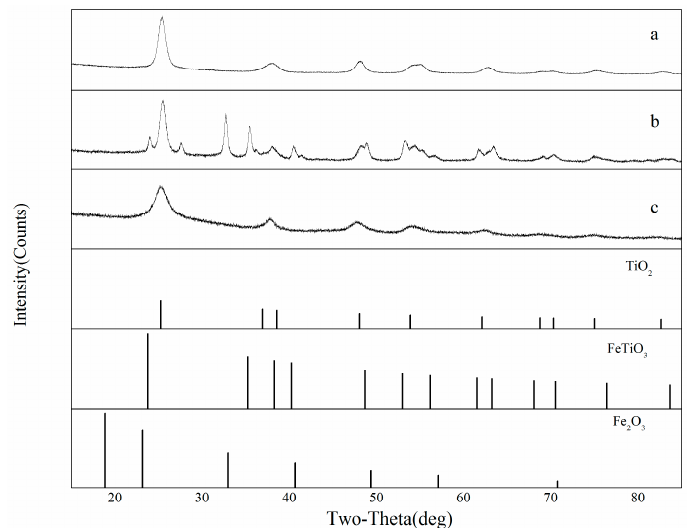
Figure 4. FTIR spectra of STCF with different amounts of Fe 3+ doping.